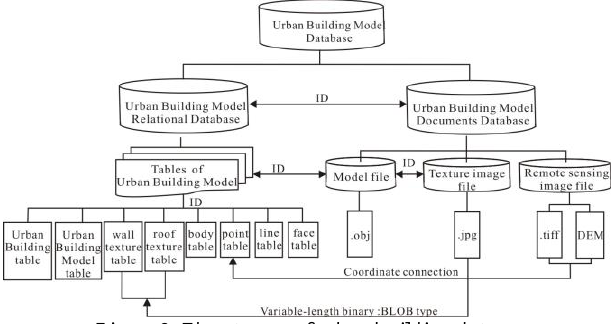
Figure 3. The storage of urban building data